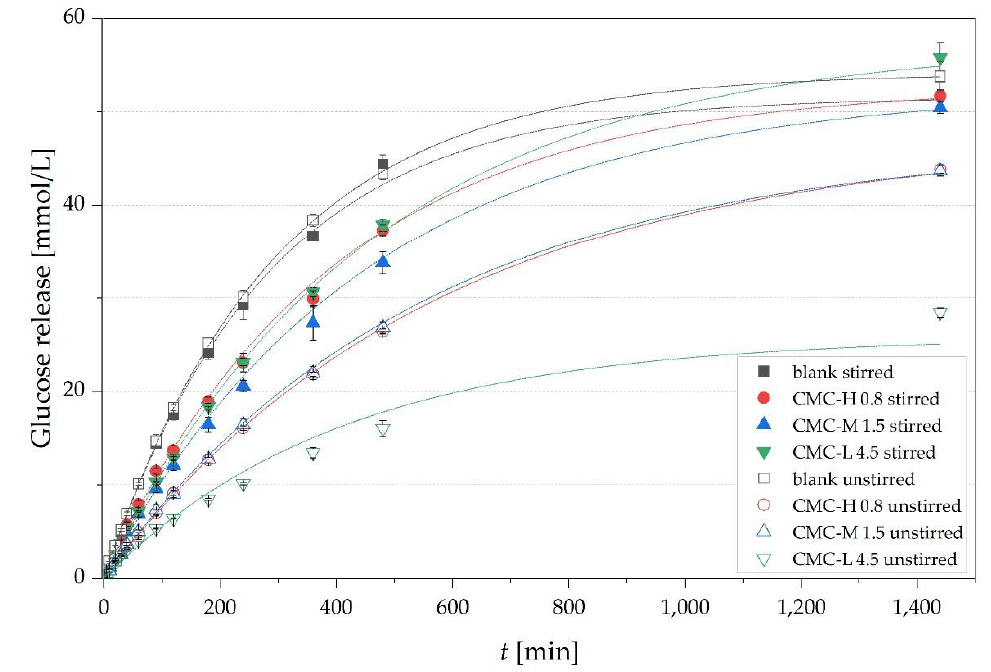
Figure 8. Time-dependent glucose release from CMC-H, CMC-M and CMC-L at their highest concentration of 0.8 g/100 g, 1.5 g/100 g and 4.5 g/100 g, respectively, and the blank with and without stirring (150 rpm). Points correspond to experimental data and lines to fitted data according to equation 3 (R 2 ≥ 0.9998).